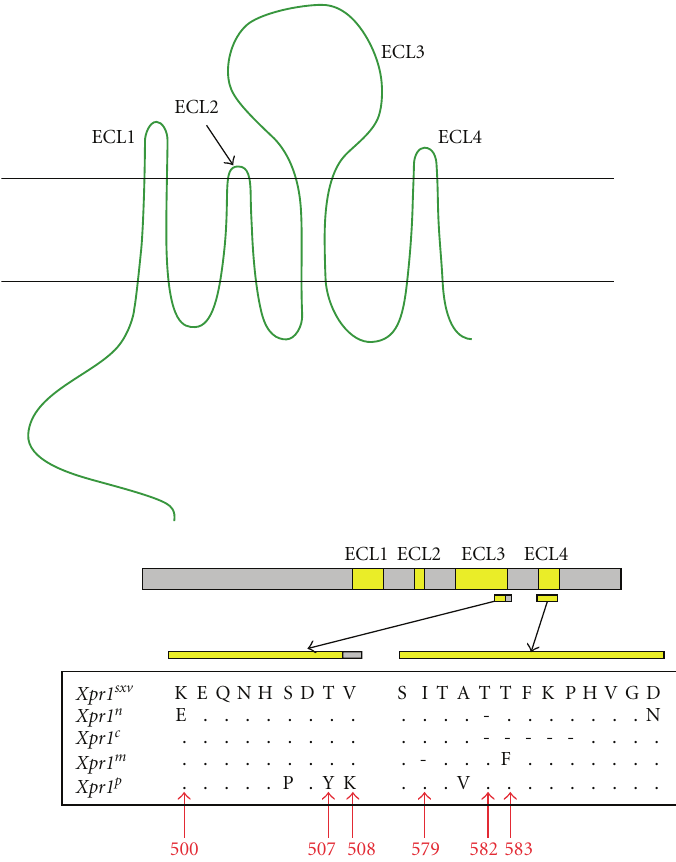
Figure 5: Predicted topology and sequence variation of the XPR1 receptor for XP-MLVs. At the top is shown the predicted structure with eight putative transmembrane domains and 4 extracellular loops (ECLs). The center diagram shows the relative locations of the 4 ECLs in the XPR1 protein, and the bottom shows sequence variation in the two ECLs involved in virus entry. Sequence is provided for the 5 functional XPR1 variants in Mus , and the red arrows indicate the 6 residues involved in